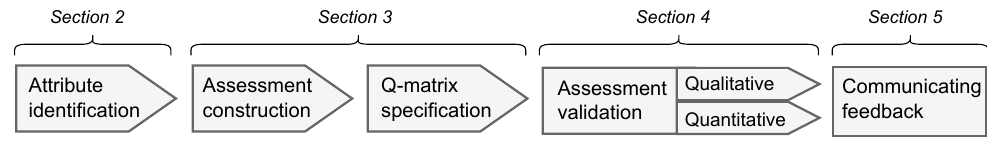
Figure 1. Outline of the current